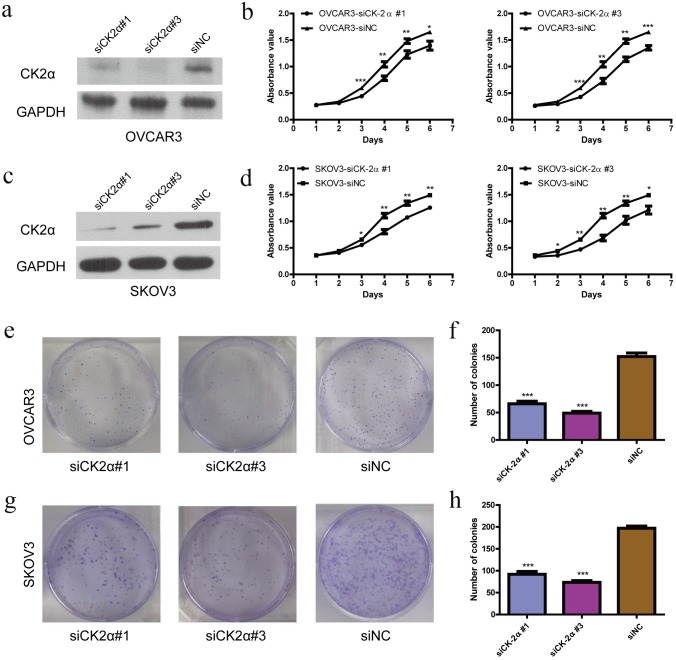
Growth-inhibiting role of knockdown CK2α in OVCAR3 and SKOV3 cell lines.(a, c) The knockdown efficiency of selected CK2α-targeting siRNAs in transfected cells was evaluated by western blotting, and the MTS assay showed that the silencing of CK2α suppressed the proliferation of OVCAR3 (b) and SKOV3 (d) cell lines. (b, d) The difference arose from Day 2 or Day 3 and persisted until Day 6. (e-h) Colony-formation assays indicated decreased growth rates in CK2α-silenced OVCAR3 (e and f) and SKOV3 (g and h) cell lines. One independent experiment was carried out in triplicate. Values are shown as the mean ± standard deviation (SD). Use independent Student's t-test to calculate P-values. *P < 0.05 vs. the control; **P < 0.01 vs. the control; ***P < 0.001 vs. the control.